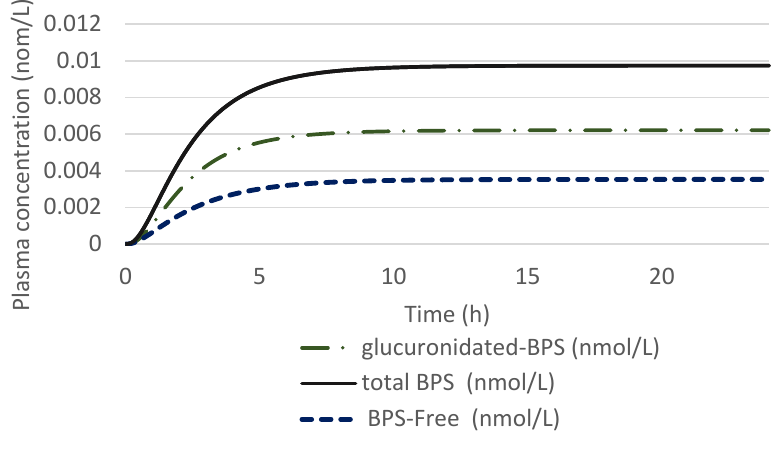
Figure 2. Estimated free BPS and glucuronidated BPS plasmatic concentrations (nmol/L) for a 70 kg adult after 24 h constant and continuous oral exposure to 0.0266 µg BPS/kg bw averaged over 24 h in the general population.